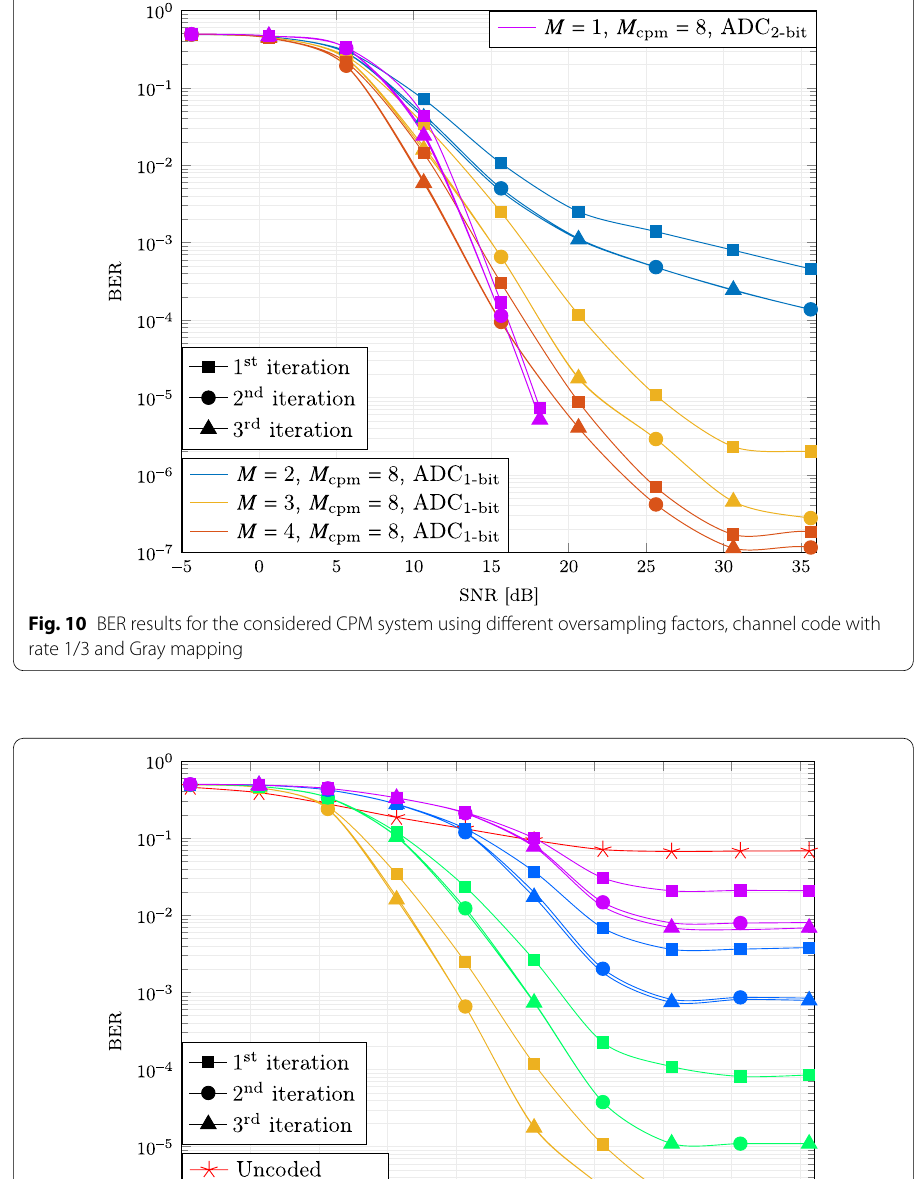
01 01 10 10 01 11 . In contrast, the pro- | | | | | |